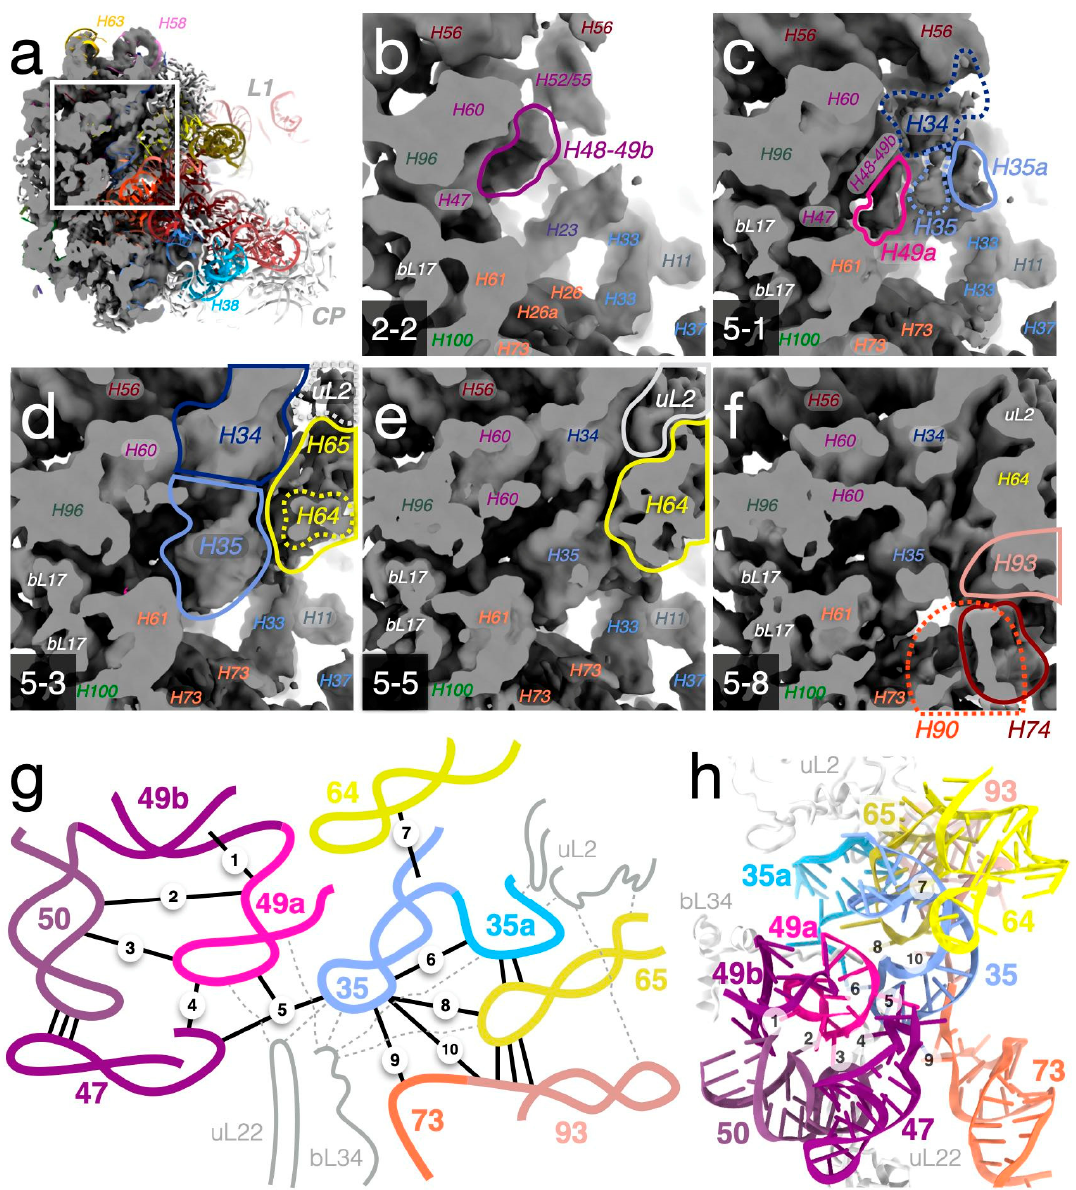
Figure 8. Structure of the H49a-H35 region in different particles suggests a local order of assembly. ( a–f ) Maps showing varying degrees of folded structure in this region. Lines indicate densities that differ between maps (the dashed lines indicate weak/diffuse densities). The maps are not sharpened, or low-pass filtered, and are shown at a level of 0.05. Figure S15 shows the same view for all particle classes. ( a ) The overview shows the consensus map and a mature model, PDB ID 4YBB, colored as in Figure 2b. ( b ) In class 2-2, H48 is folded, but not H49a. ( c ) Densities for H34, H35, and H35a outside of H49a in class 5-1. ( d , e ) Occupancy for H64, H65, and uL2 is partial in class 5-3, but close to full in 5-5. ( f ) Helices H90, H93, and H74 are folded into class 5-8. ( g ) Schematic view of stabilizing interactions in the H49a-H35 region. Tertiary contacts for H49a and H35 are indicated with solid lines and numbered 1–10 in the approximate assembly order, as deduced from the maps (see Sections 3.9.1 and 3.9.2). Dashed lines indicate contacts to r-proteins. ( h ) Structure of helices and r-proteins in ( g ) in the mature 50S (PDB ID 4YBB), tertiary contacts are numbered 1-10 as in ( g